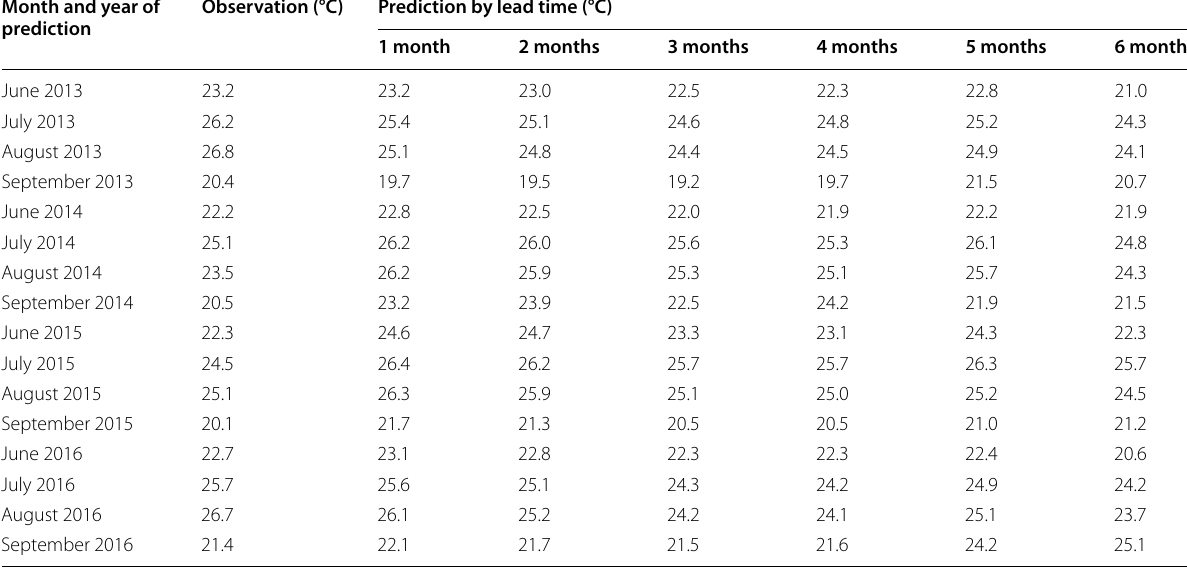
Table 6 Results of the temperature prediction model based on teleconnection Month and year of Observation (°C) Prediction by lead time (°C) prediction 1 month